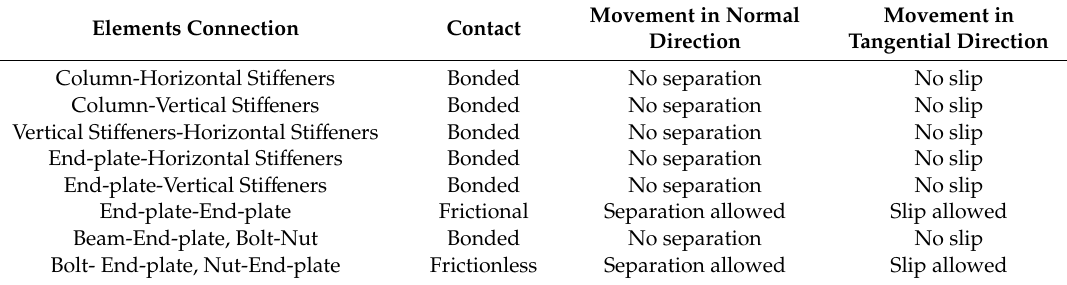
Table 6. Type of contacts used in the numerical models.